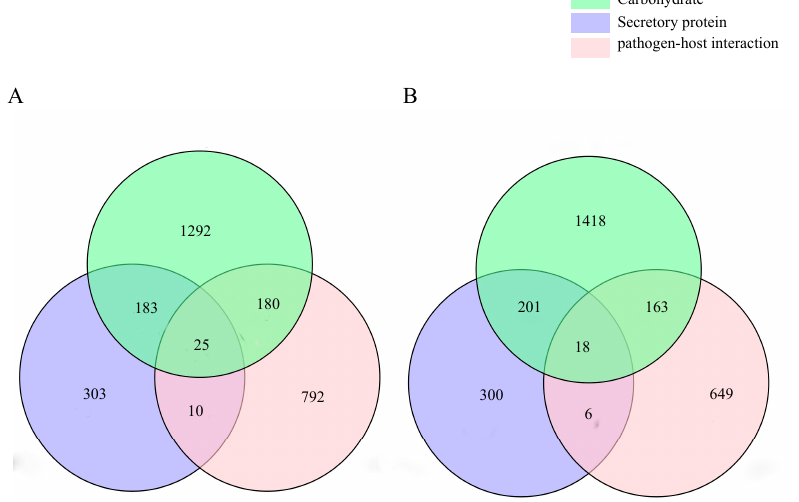
Figure 8. Relationships between genes in the three annotated plates of strains QK8 ( A ) and SX13 ( B ).